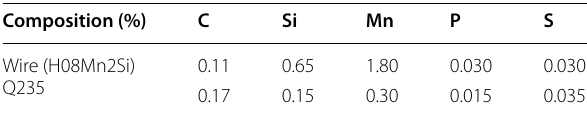
Table 1 Chemical compositions of welding wire and base metal